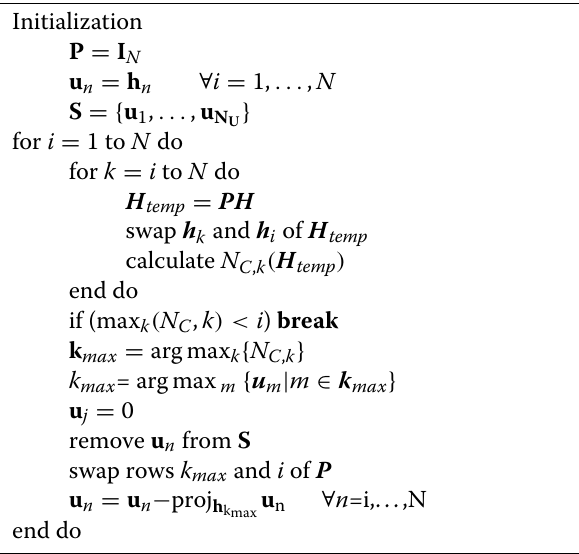
Algorithm 2 (MoL,P) RC